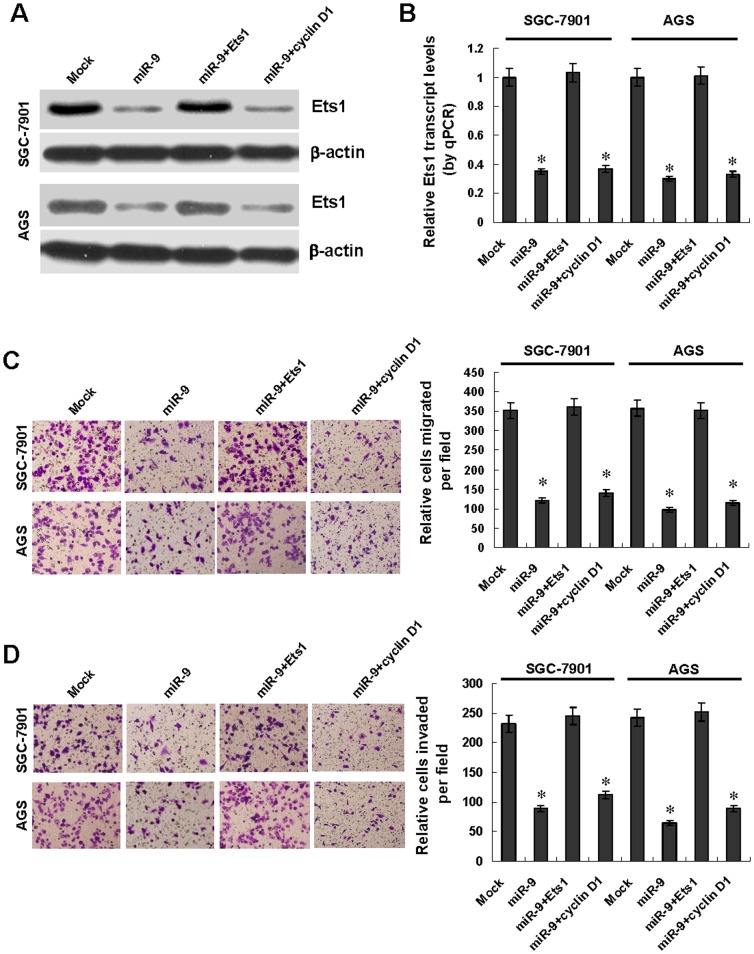
Over-expression of miR-9 attenuated the in vitro migration and invasion of gastric cancer cells through targeting Ets1.
A and B, western blot and real-time quantitative RT-PCR indicated that transfection of Ets1, but not of cyclin D1, restored the down-regulation of Ets1 induced by miR-9 over-expression in gastric cancer SGC-7901 and AGS cells, when compared to those transfected with negative control vector (mock). C, in transwell migration assay, gastric cancer cells stably transfected with miR-9 precursor presented an impaired migration capacity than that in mock cells, which was rescued by transfection of Ets1, but not of cyclin D1. D, in matrigel invasion assay, miR-9 over-expression attenuated the invasion capabilities of SGC-7901 and AGS cells than those of mock cells, which was rescued by transfection of Ets1, but not of cyclin D1. The symbol (*) indicates a significant decrease from mock.